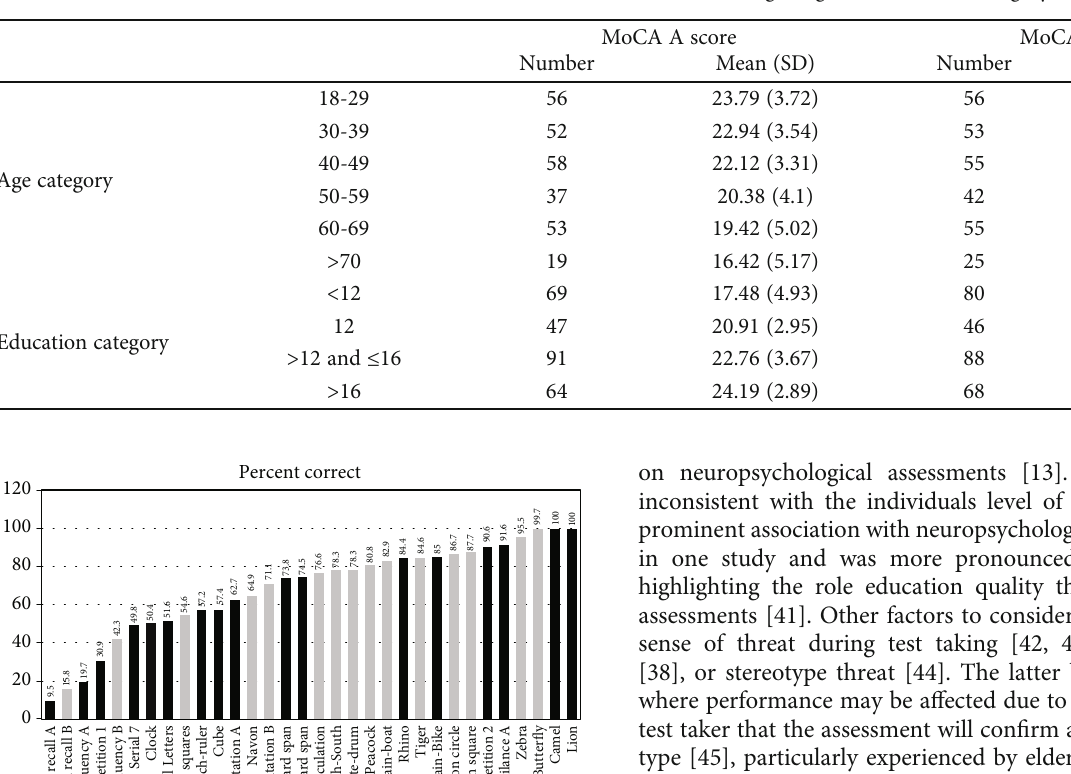
Table 2: Scores on the MoCA-A and MoCA-B versions according to age and education category.